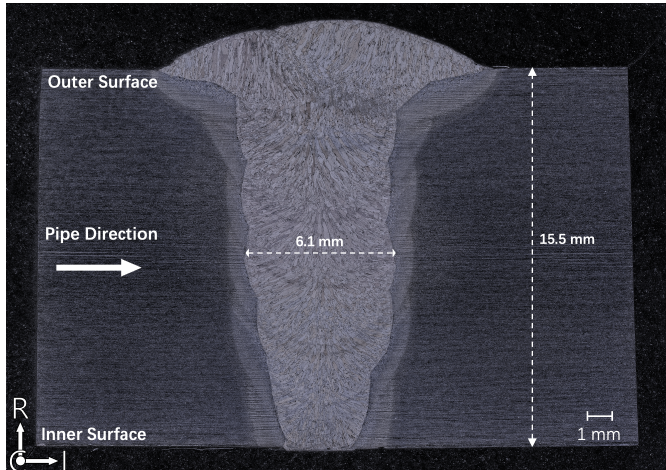
Figure 1. Macrostructure of the X60 girth weld. Relevant dimensions are annotated; the pipe-wall thickness is approximately 15.5 mm, the width of the weld is roughly 6.1 mm. The inner and outer surfaces are indicated, as well as the pipe direction. The orientation of the material in the pipe is indicated: L—Longitudinal, C—Circumferential and R—Radial. Etchant: nital (5%).